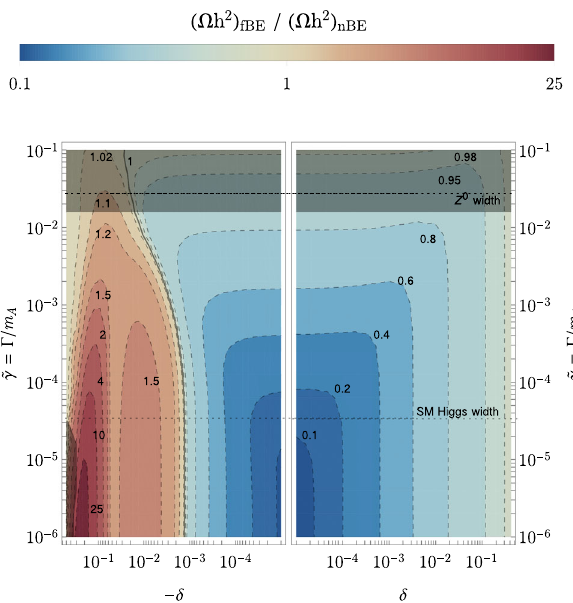
Fig. 3 Contour lines of constant (Ω χ h 2 ) fBE /(Ω χ h 2 ) nBE in the δ − ˜ γ planeforamodelwith m χ = 1GeVand r = 0 . 3.AsinFig.2,couplings are fixed such that 2 (Ω χ h 2 ) nBE = Ω DM h 2 , and δ = ( 2 m χ / m A ) 2 − 1. Red (blue) colors highlight regions where the early kinetic decoupling effect overall increases (decreases) the predicted relic abundance com- pared to the standard treatment. Dotted black lines show, for compari- son, the widths of the SM Z 0 and Higgs bosons. The gray shaded areas on the edges of the plot indicate parameter regions where the ρ value satisfying the relic density condition cannot be achieved without violat- ing perturbativity or by extending the model (see text for more details)